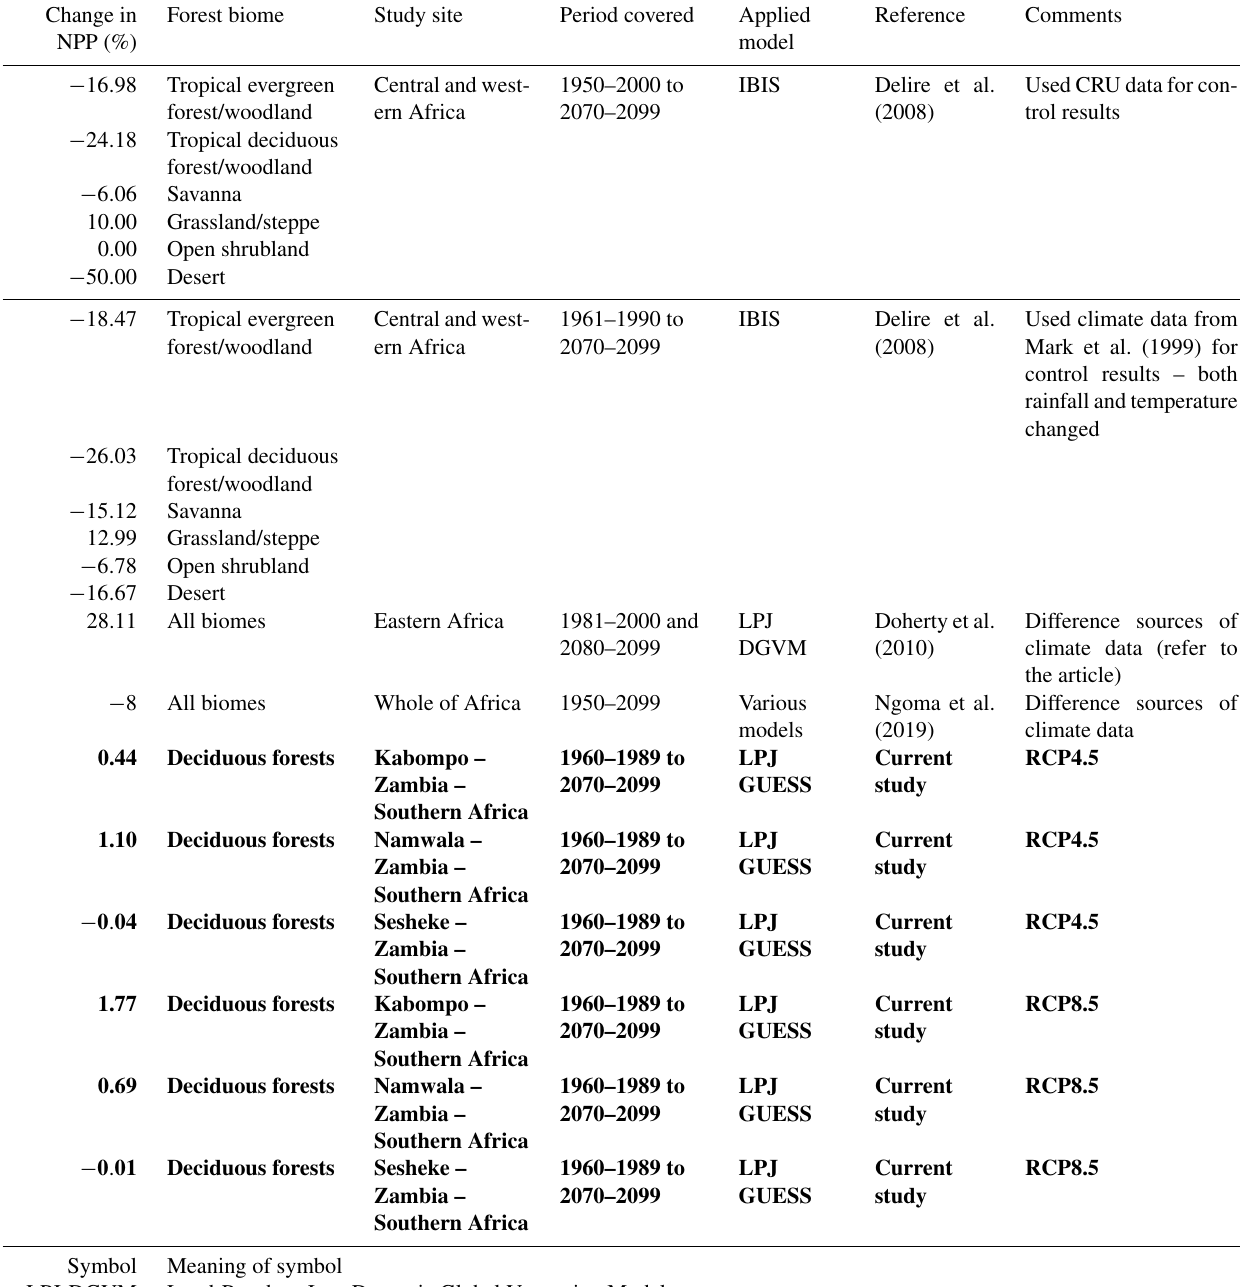
Table 3. Projected changes in NPP: current study compared to the literature. A negative sign ( − ) under “Change in NPP (%)” means a reduction in NPP. Results from the current study are shown in